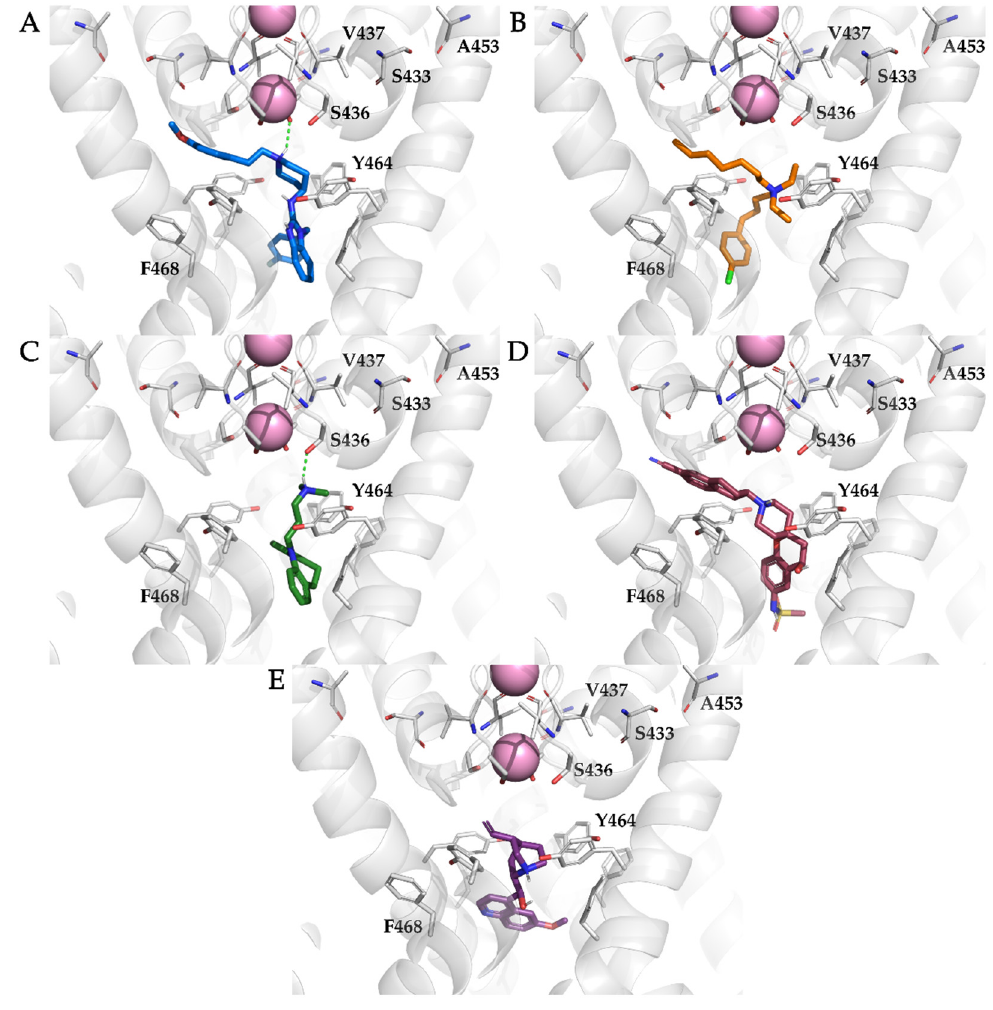
Figure 5. Docking poses within the homology model of the K V 10.1 open pore conformation of astemizole (( A ); blue sticks), clofilium (( B ); orange sticks), imipramine (( C ); green sticks), MK-499 (( D ); pink sticks), and quinidine (( E ); magenta sticks) selected for molecular dynamics simulations. The K V 10.1 amino-acid residues reported in the literature as important for the binding of the ligands used in this study are labeled and shown as gray sticks. Potassium ions are shown as pink spheres. Hydrogen bonds are shown as green dashed lines.